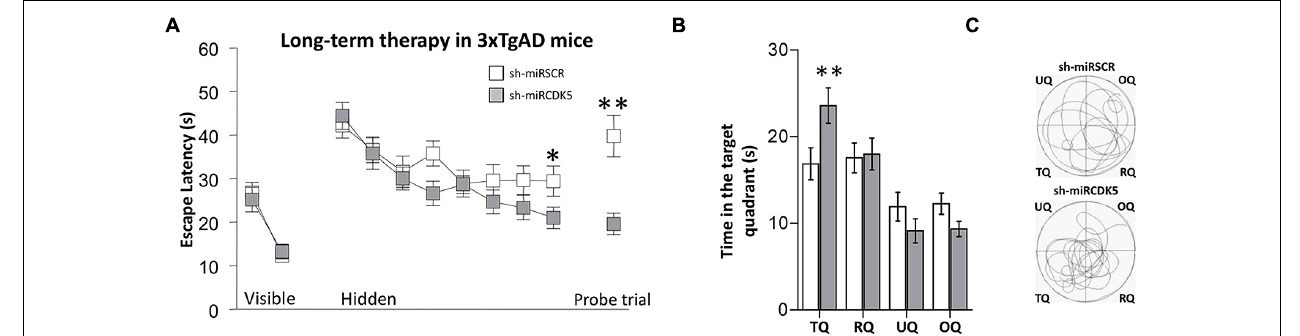
and probe trial tests at 48 h. This effect was replicated in (B) time spent in the target quadrant and (C) path plots for the median path length. (TQ = target quadrant, RQ = Right quadrant, UQ = upper quadrant and OQ = oppositive quadrant.) Data are presented as mean ± SEM. n = 18 by each group, * p < 0.05, ** p <